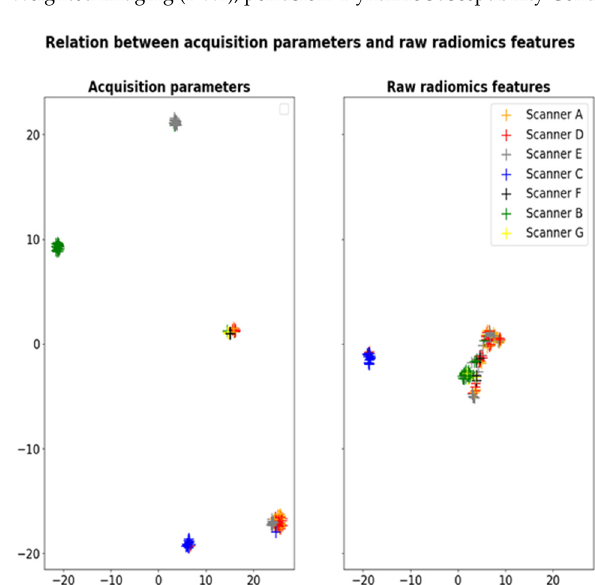
Echo time (TE) and repetition time (TR) are given in milliseconds (ms) and flip angle (FA) in de- grees (°). A to G refer to the identification letters assigned to the different MRI scanners in this study. Anatomical images: T1-weighted (T1w), T2-weighted (T2w) and Fluid-attenuated Inversion Recovery (FLAIR); diffusion: Diffusion Weighted Imaging (DWI); perfusion: Dynamic Susceptibil- ity Contrast (DSC).